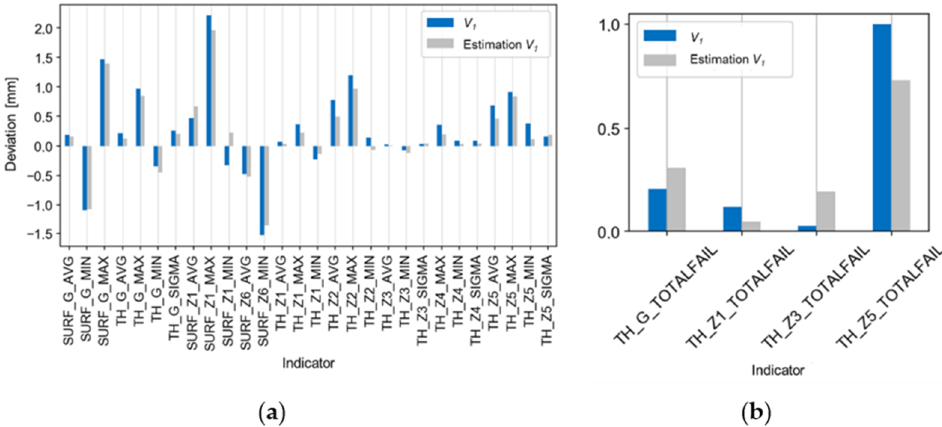
Figure 13. Comparison of the estimate of the results of the V 1 trial (based on regression models) with the actual results of the trial for the indicators of ( a ) deviations and ( b ) tolerances.